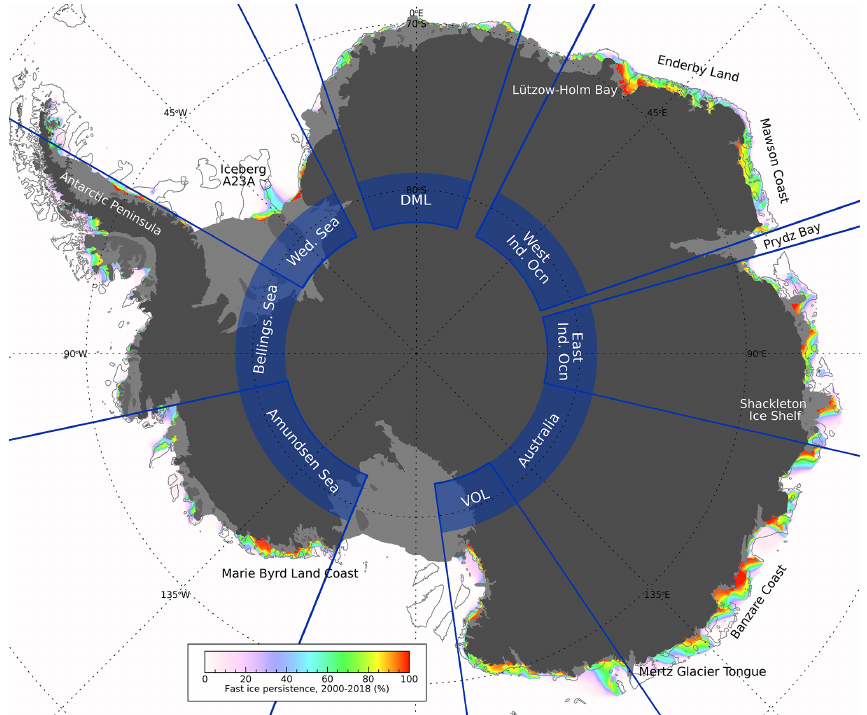
Figure 2. Distribution of fast-ice persistence, expressed as a percentage of time covering each pixel from March 2000 to March 2018. Fast-ice region boundaries are indicated by blue radial lines. Gaps between regions occur in areas of minimal fast-ice coverage. The 403m isobath, corresponding to the weighted-mean circumpolar fast-ice depth, is indicated as a grey contour. DML is Dronning Maud Land and VOL is Victoria and Oates Lands. The early-2000 position of large tabular, grounded iceberg A23A is indicated here in black outline, in the southern Weddell